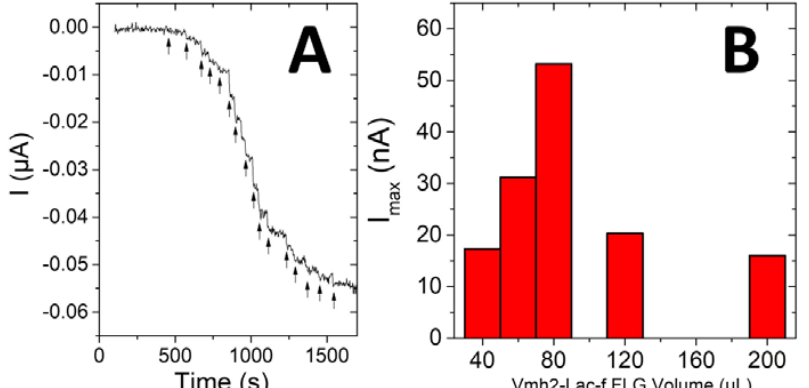
Figure 4. ( A ) Chronoamperometry performed at Lac-Vmh2-biofunctionlized FLG electrode after successive additions of catechol (indicated by the arrows, applied potential = − 0.2 V vs. saturated calomel electrode (SCE), 0.1 M Phosphate-buffered saline (PBS), pH 6, 25 °C). ( B ) Plot of the maximum current towards volume of drop-coated Lac-Vmh2-biofunctionlized FLG solutions .